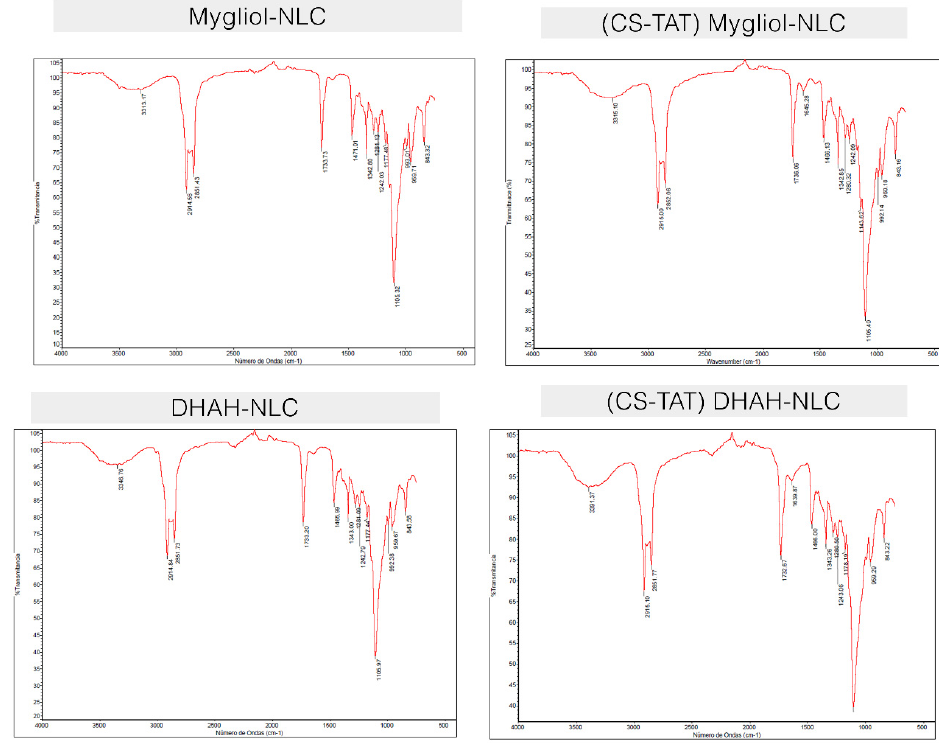
Figure A2. FTIR spectra of Mygliol-NLC, (CS-TAT) Mygliol-NLC, DHAH-NLC and (CS-TAT) DHAH-NL.